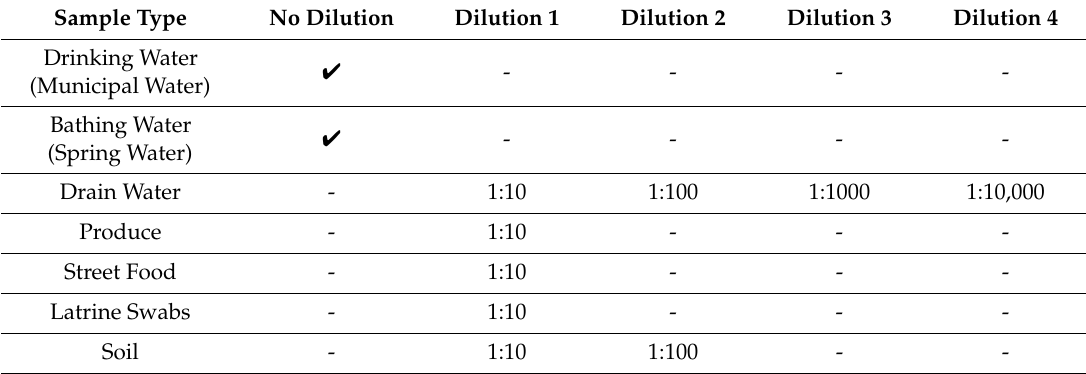
Table 1. Recommended dilutions for sample